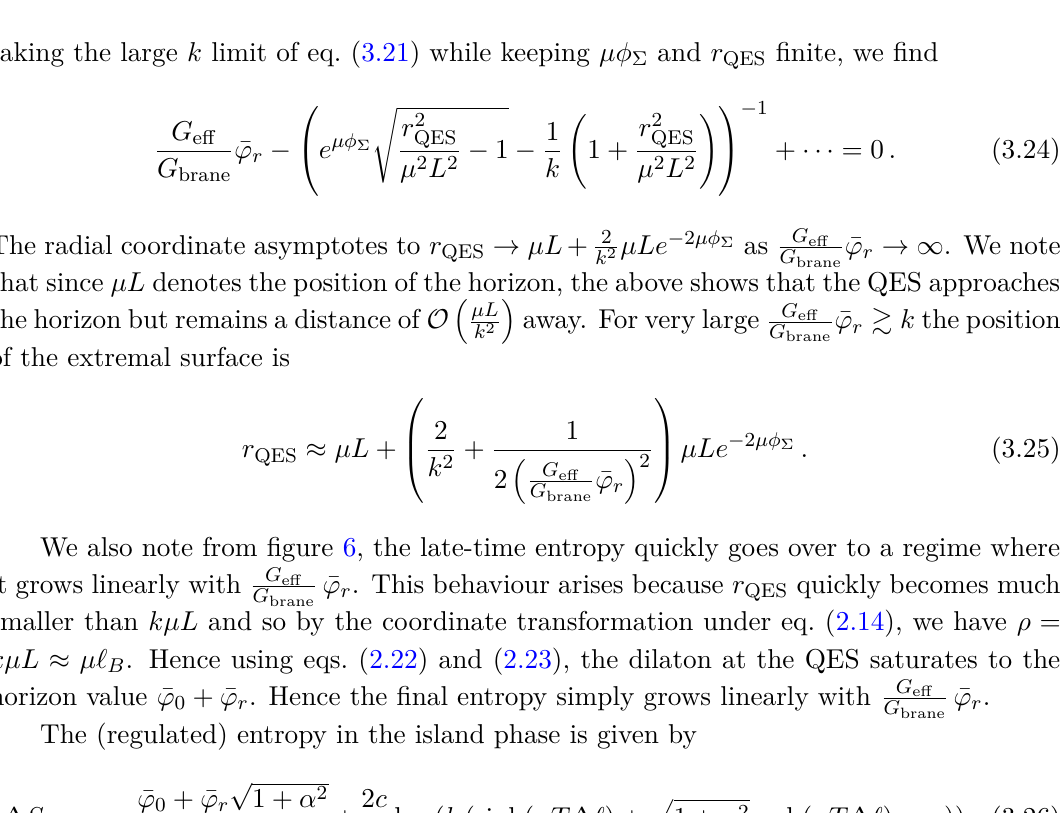
contribution to the 0